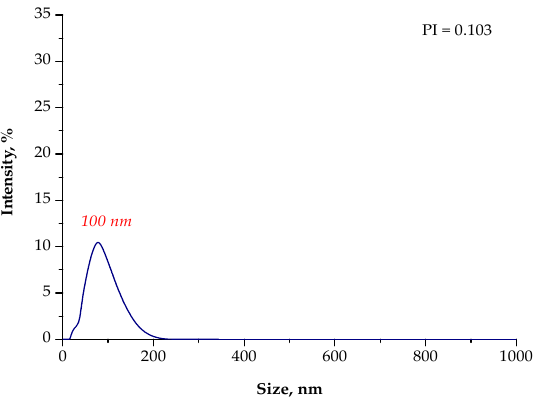
Figure 6. The size analysis of the particles in the suspension obtained as a result of the synthesis performed using the 3% Arabic gum solution after 4 h of